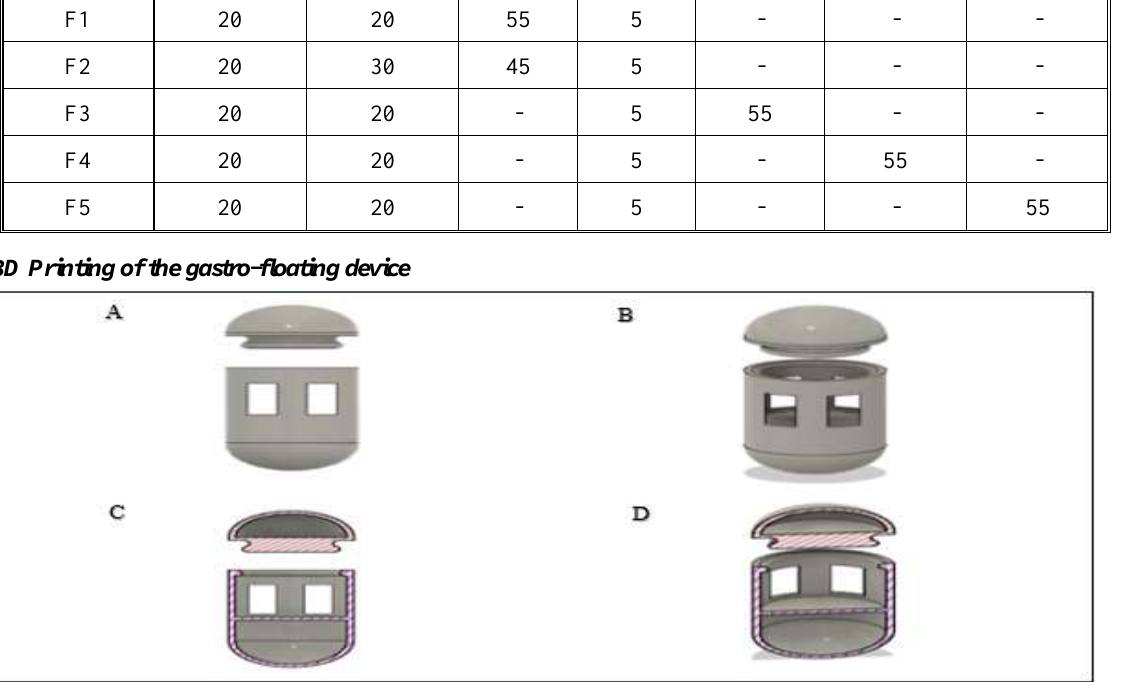
Figure 1. 3D design of the gastro-floating device, (A) Front view, (B) Side view, (C) Front sectional view, and (D) Side sectional